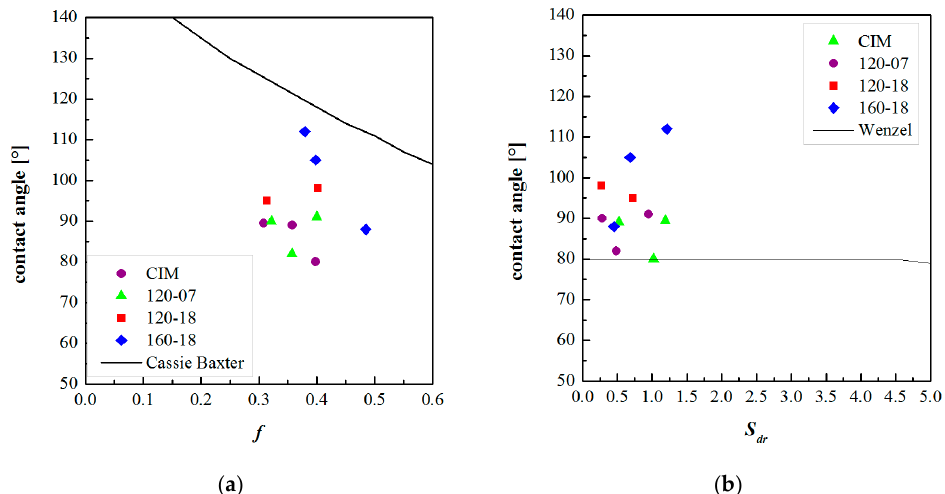
Figure 10. Contact angles vs. the parameters S dr ( a ) and f ( b ) calculated on the AFM maps where a high pass filter of 0.2 μ m − 1 was applied. The Wenzel and the Cassie–Baxter models were also reported in each plot.